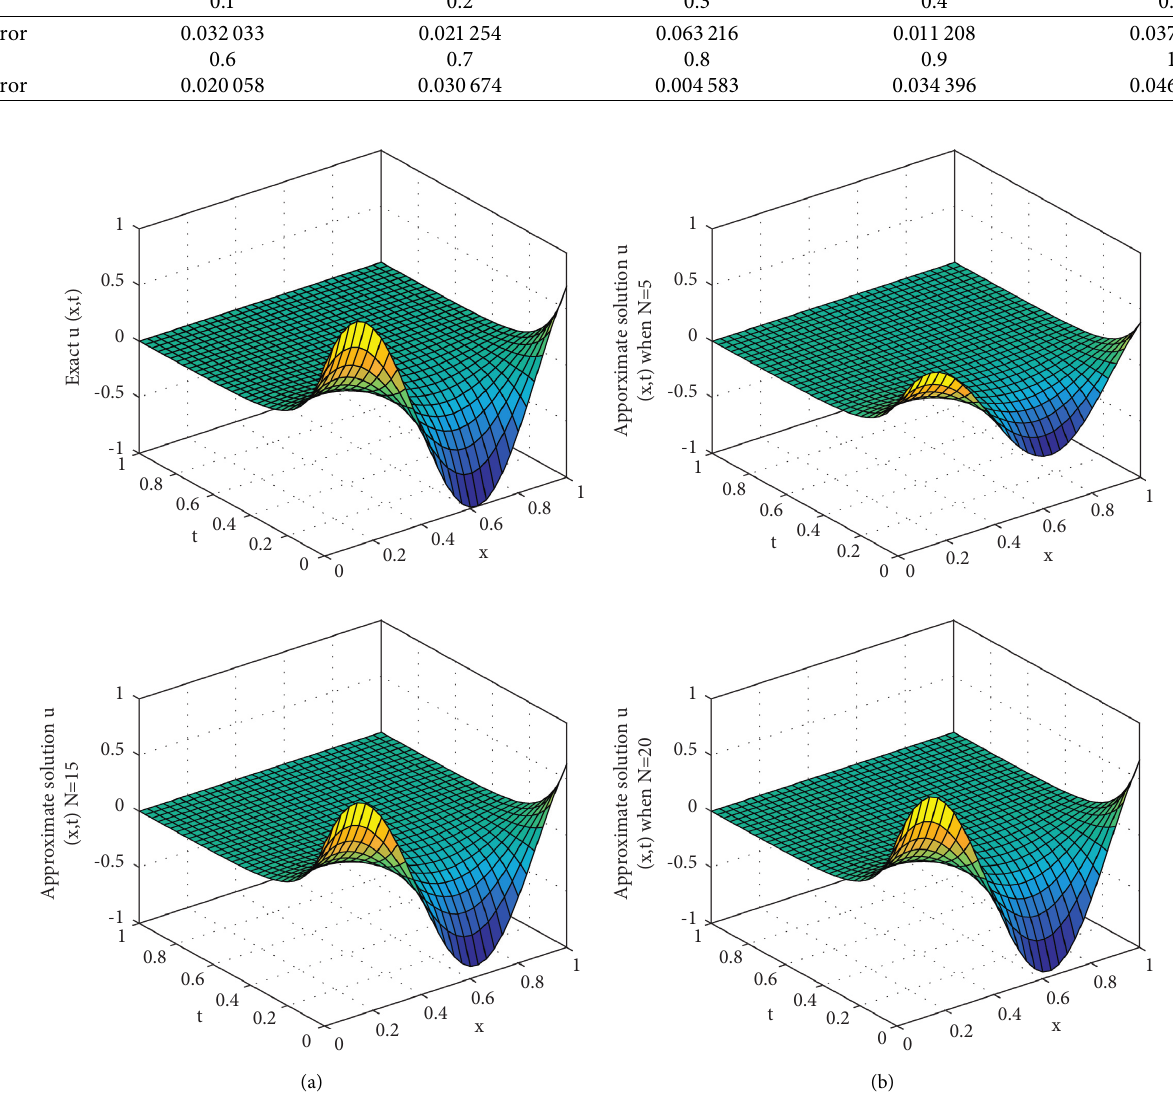
Figure 3: Reconstructions of Example 2. (a) First line: exact solution of u ( x,t ) (left); approximate solution of u ( x, t ) when N � 5 (right); (b) second line: approximate solutions of u ( x,t ) when N � 15 (left) and N � 20 (right), respectively.